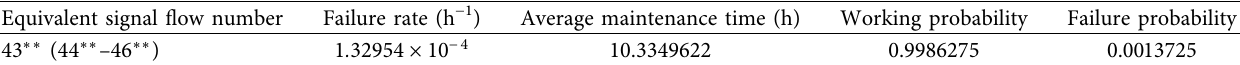
Table 9: Reliability parameters of operator 43 ∗∗ (44 ∗∗ –46 ∗∗ ).